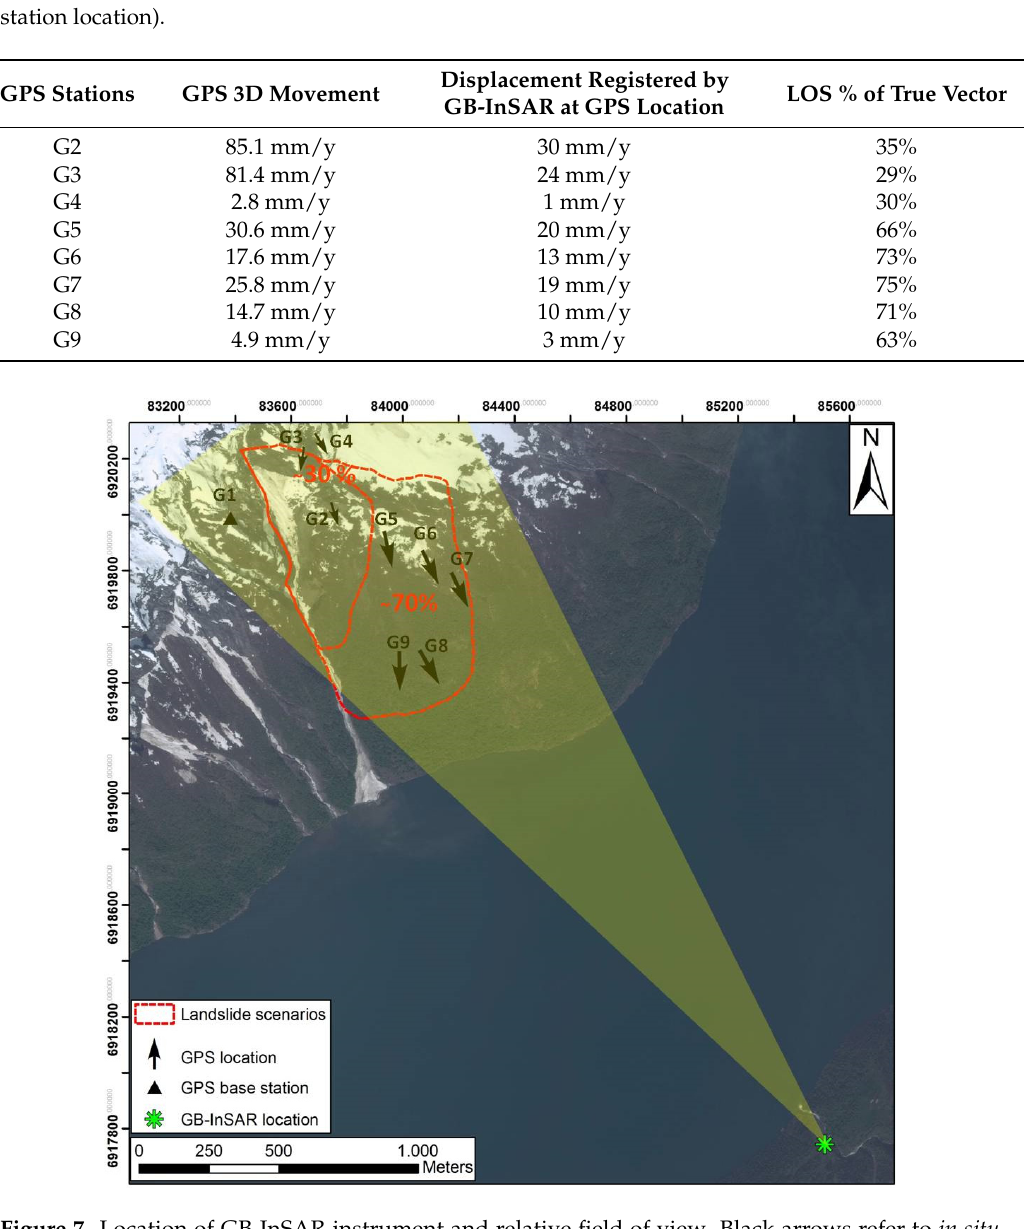
Figure 7. Location of GB-InSAR instrument and relative field of view. Black arrows refer to in situ instruments (GPS); their size is proportional to the percentage of displacement, registered by GPS instruments, and detected by GB-InSAR. The upper portion of the slope is less detectable (about 30%) than the lower sector (about 70%) from the GB-InSAR location. Background ortophoto is obtained from Virtual Earth imagery; GPS data from [49].